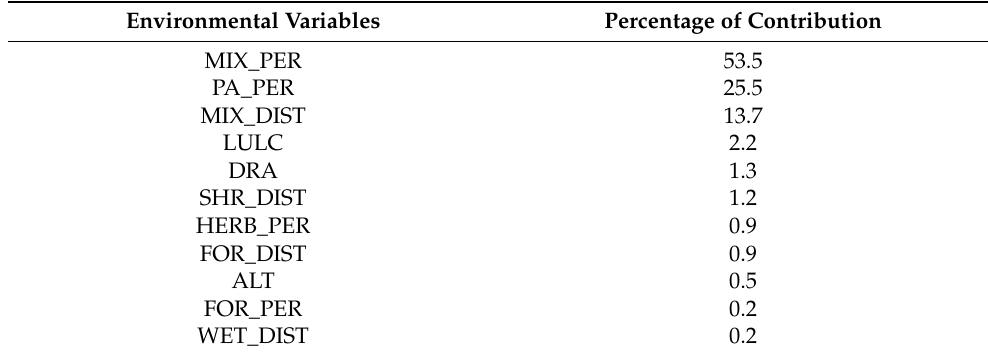
Figure 2. Habitat suitability map for Cx. pipiens-restuans . Table 4. Percentage of contribution of each environmental variable. Only variables with a percentage of contribution higher than zero are represented.